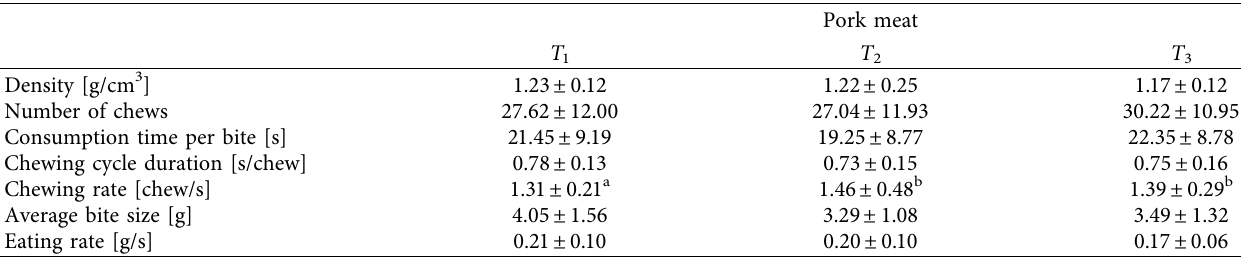
Table 2: Summary of the oral processing behavior parameters for pork meat samples prepared using three grilling working